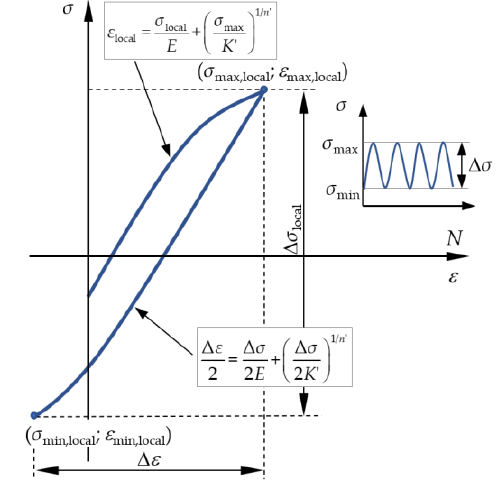
Figure 5. Hysteresis loop in the weld notch.